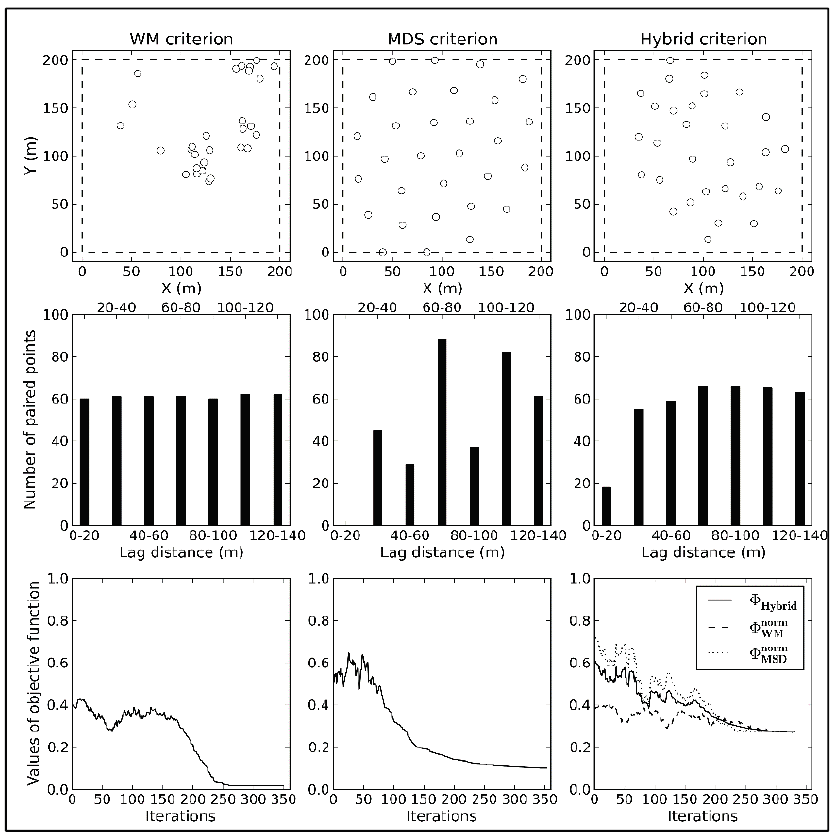
Figure 4. Differences in spatial distribution, number of paired points and values of objective function between three optimization